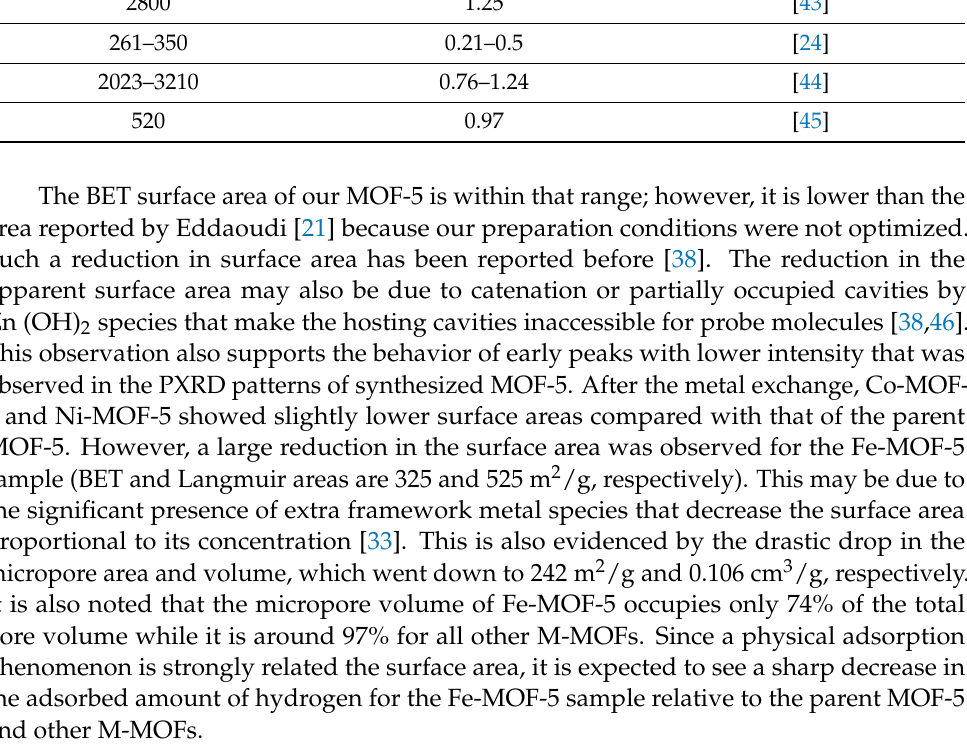
Table 3. The gravimetric hydrogen adsorptions of MOF-5, Co-MOF-5, Ni-MOF-5, and Fe-MOF-5 were 1.46, 1.53, 1.53, and 0.99 wt%, respectively. Both Ni-MOF-5 and